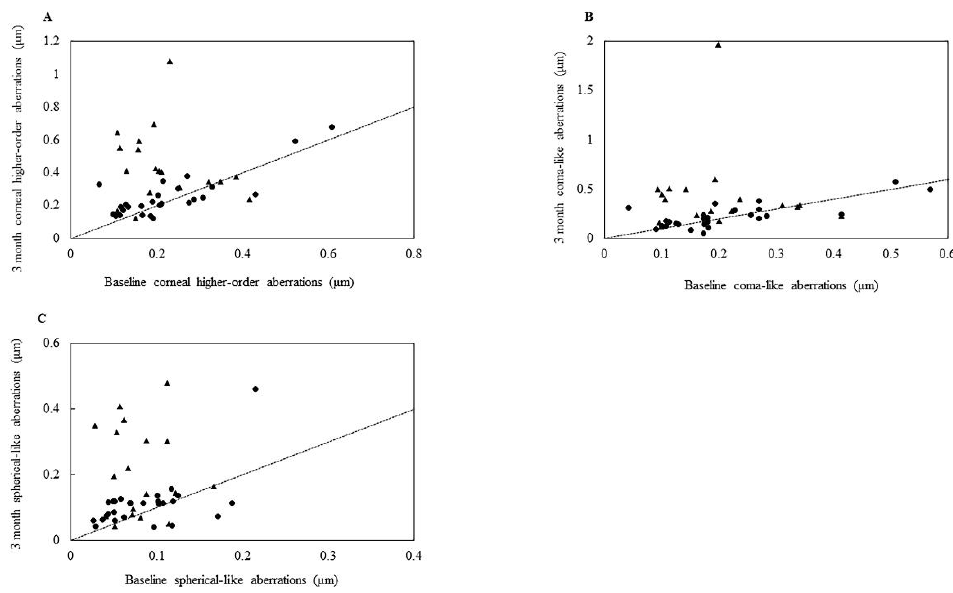
Figure 2. Scatterplot showing baseline versus 3-month corneal higher-order ( A ), coma-like ( B ), or spherical-like aberrations ( C ). Filled circle 120° EIS group; filled triangle 180° EIS group. Table 4. Stepwise multiple regression analysis for factors associated with postoperative corneal higher-order, coma-like, The risk factor that was identified as being associated with the increased corneal and spherical-like aberrations’ HOAs, coma-like aberrations, and spherical-like aberrations at 3 months after